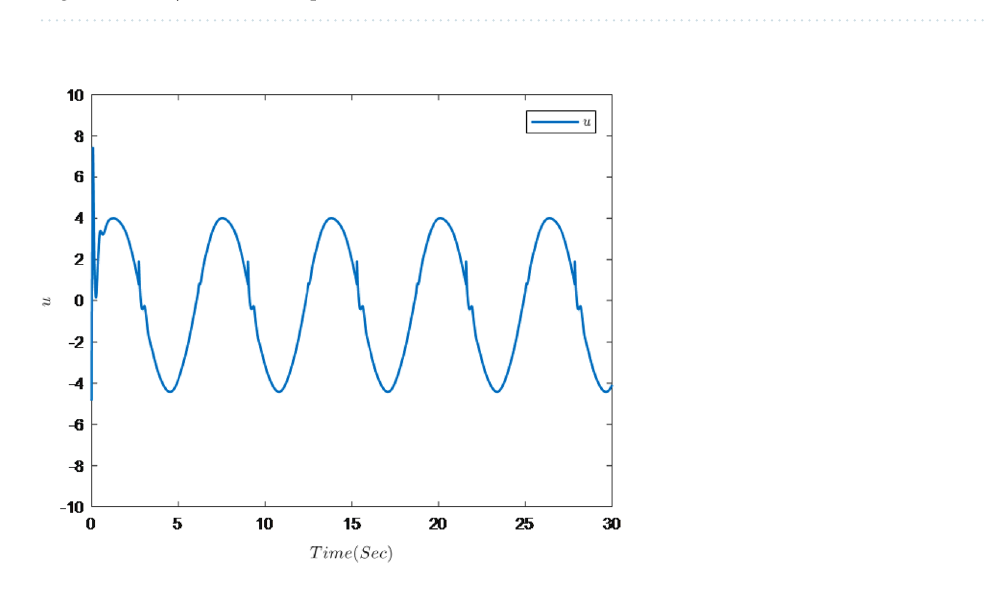
Figure 10. Trajectories of adaptive law θ 1 θ 2 θ 3 .